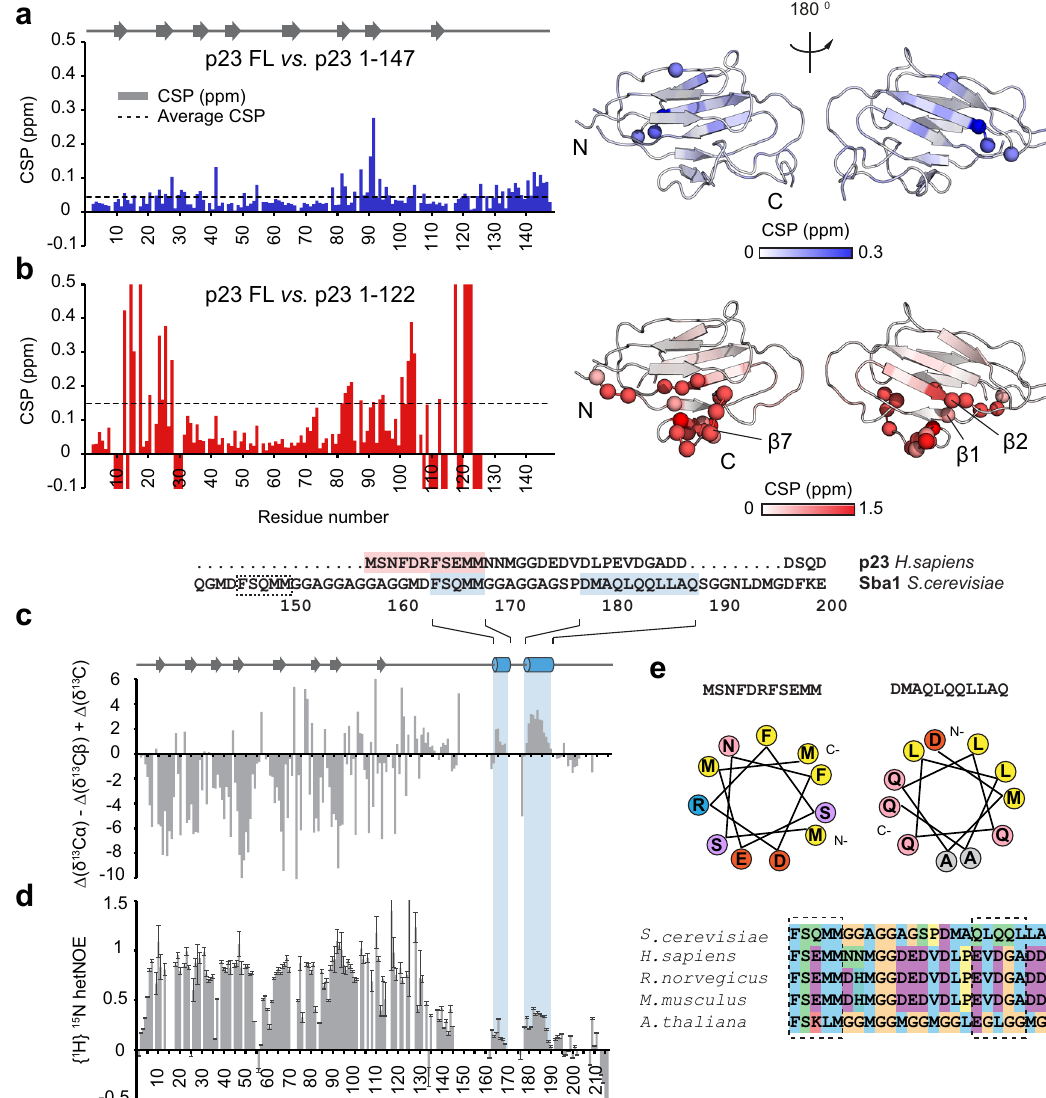
Fig. 3 NMR analysis of different constructs of p23. Comparing chemical shift differences of the deletion mutants show that the p23 Δ 69 (1-147) mutant ( a ) is largely unaffected by the truncation of the tail. However, ( b ) the p23 Δ 94 mutant (1-122) reveals signi fi cant changes of the chemical shifts. Residues with a negative value indicate NMR signals which are absent in the NMR spectra of the tail-deleted construct. The spectral changes associated with tail deletions are plotted on the crystal structure of p23/Sba1 shown on the right. Color saturation indicates the strength of the chemical shift perturbation. Residues undergoing large chemical shift changes are shown as spheres. ( c ) Secondary 13 C chemical shifts comparing differences in the C α , C β , and C ′ values versus random coil values of p23 WT (1 – 216). Positive and negative secondary chemical shifts are indicative of α -helical and β -strand conformation, respectively. Secondary structure elements are indicated at the top and highlighted in blue for yeast. In addition, the sequence alignment of human p23 is included, with the helical motifs highlighted in blue (yeast) and red (human). An additional predicted helical motif in yeast is indicated by a dotted box. d { 1 H}- 15 N heteronuclear NOE values obtained from the ratio of peak intensities of saturated vs. non-saturated experiments. Values around 0.78 correspond to rigid regions. Lower values correspond to increasing fl exibility at sub-nanosecond timescales. Errors were estimated from spectral baseplane noise RMSD according to Farrow et al. 89 . e Polarity distribution of identi fi ed helical segments reveals their amphipathic properties. Orange/yellow colors indicate hydrophobic residues, while red/pink/blue colors represent charged amino acids. The sequence alignment shown at the bottom indicates the conservation of helical motifs in the p23 tail across different species, colored according to the Clustal